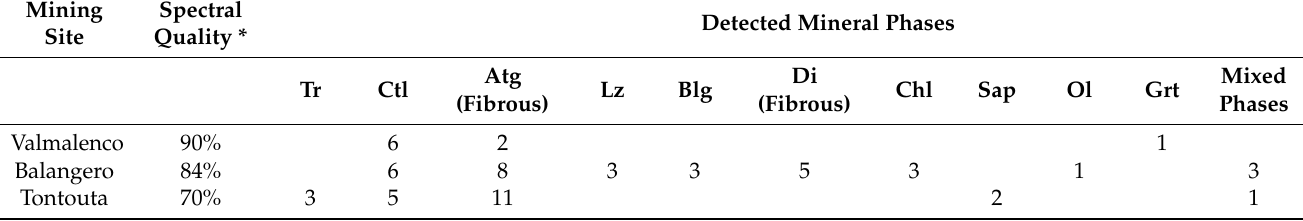
* Spectral quality = number of analyses with sufficient quality to distinguish mineral phases/number of total analyses performed × 100. Abbreviations: Tr, tremolite; Ctl, chrysotile; Atg, antigorite; Lz, lizardite; Blg, balangeroite; Di, diopside; Chl, chlorite; Sap, saponite; Ol, olivine; Grt,